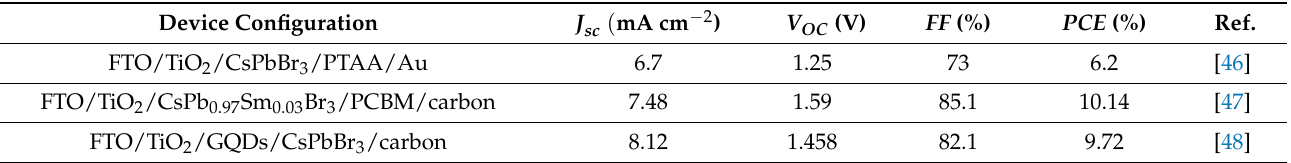
Figure 3. ( a ) Illustration of CsPbI 2 Br thin film growth via spin-coating technique; ( b ) Comparison of CsPbI 2 Br thin film growth at various temperatures; ( c ) Ultraviolet–vis absorption spectra; ( d ) Photo luminescence spectra; ( e ) decay plots; ( f ) J - V curves; ( g ) EQE spectra; ( h ) efficiency histograms of twenty devices. Adapted with permission from [45]. Table 1. Performance characteristics of various devices fabricated via two-step solution processing